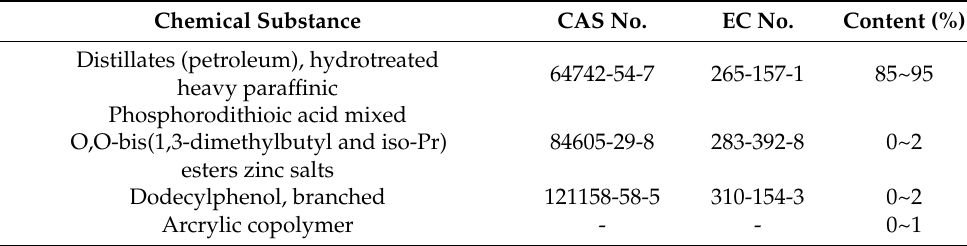
Table 2. Chemical composition of lubricant